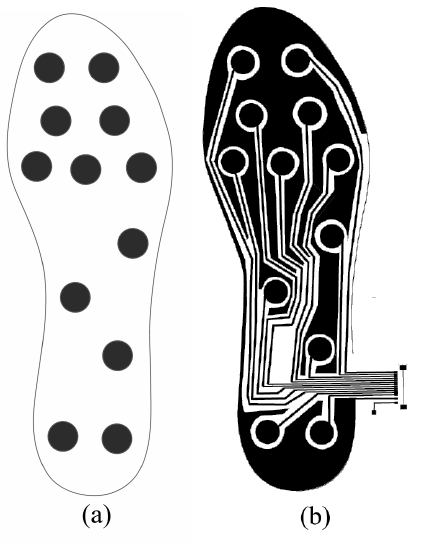
Figure 2. ( a ) Location of the sensors in the proposed capacitive insole. ( b ) Layout of the layer with the electrodes on the capacitive plantar